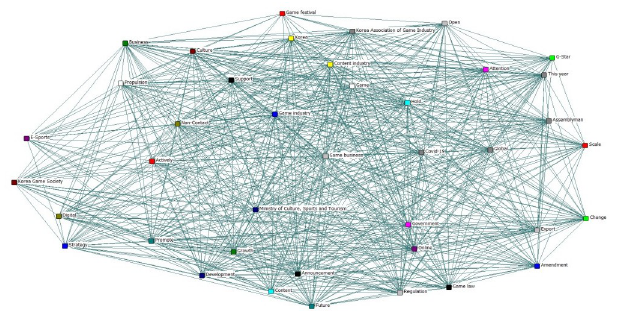
Fig 1. Overall network for game industry related